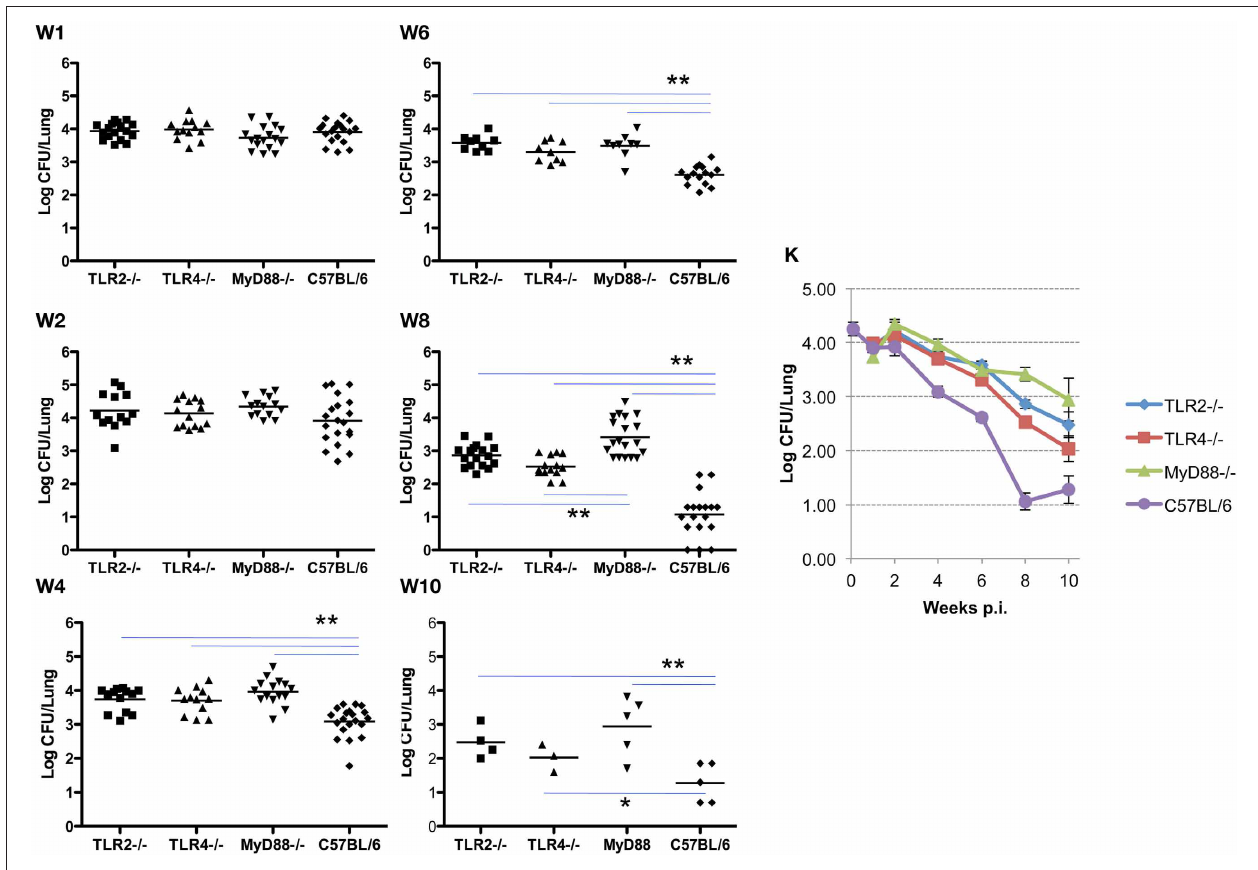
FIGURE 1 | TLR signaling is required for efficient clearance of Brucella from the lungs. Groups of TLR2 − / − , TLR4 − / − , MyD88 − / − and C57BL/6 mice were aerosol exposed to B. melitensis 16M. The lungs were collected at weeks 1 (panel W1 ), 2 (panel W2 ), 4 (panel W4 ), 6 (panel W6 ), 8 (panel W8 ),